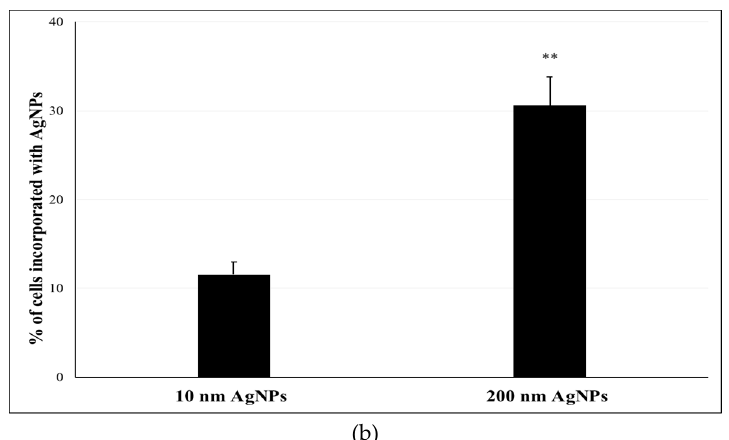
Figure 2. Uptake ratios of 10 nm and 200 nm AgNPs by NCI-H292 cells. Cells were incubated with AgNPs at a concentration of 100 µg/mL for 24 h. Cellular uptake of AgNPs was calculated using FACS based on the side scatter (SSC). ( a ) Gated forward and side scatter plot of most cells depending on the control population; the cells exposed to 200 nm AgNPs showed higher SSC in the right panel. ( b ) Percentage of cells incorporated with 10 nm and 200 nm AgNPs. The results are shown as means ± SD, n ≥ 3, for each group; ** P < 0.01.